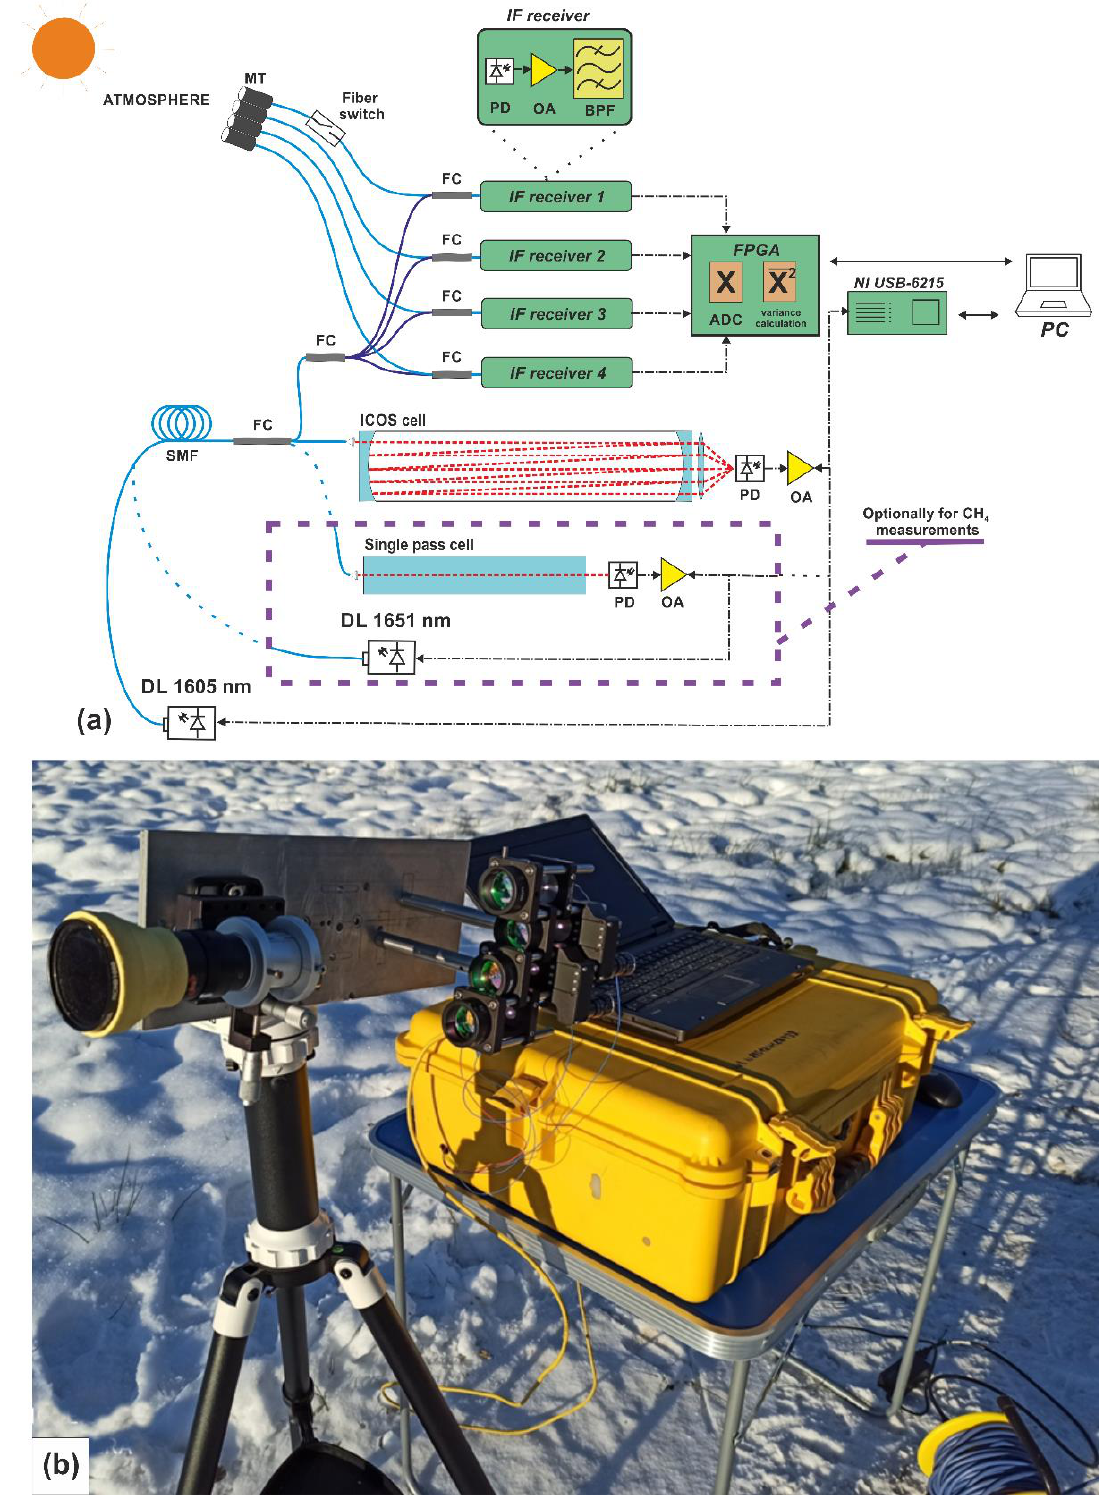
Figure 1. ( a ) The sketch of the ground-based prototype of a multichannel laser heterodyne spectroradiometer (MLHS) for atmospheric CO 2 and CH 4 measurements. DL is a diode laser; SMF is a single-mode optical fiber; FC is a fiber coupler; MT is a microtelescope; PD is a photodiode; OA is an operational amplifier; BPF is a bandpass filter. ( b ) The real form of the MLHS prototype. (For interpretation of the references to color in this figure, the reader is referred to the web version of this article).